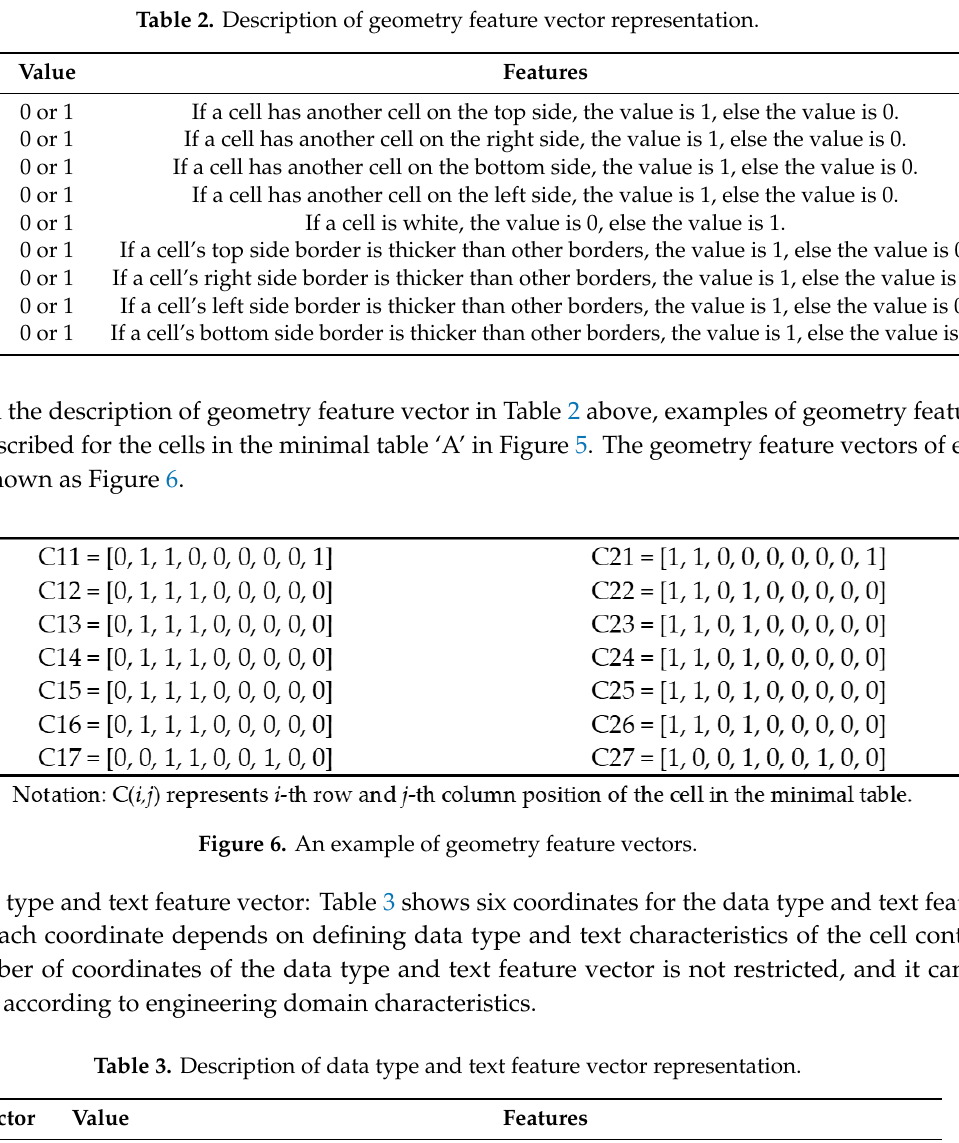
Table 2. Description of geometry feature vector representation.